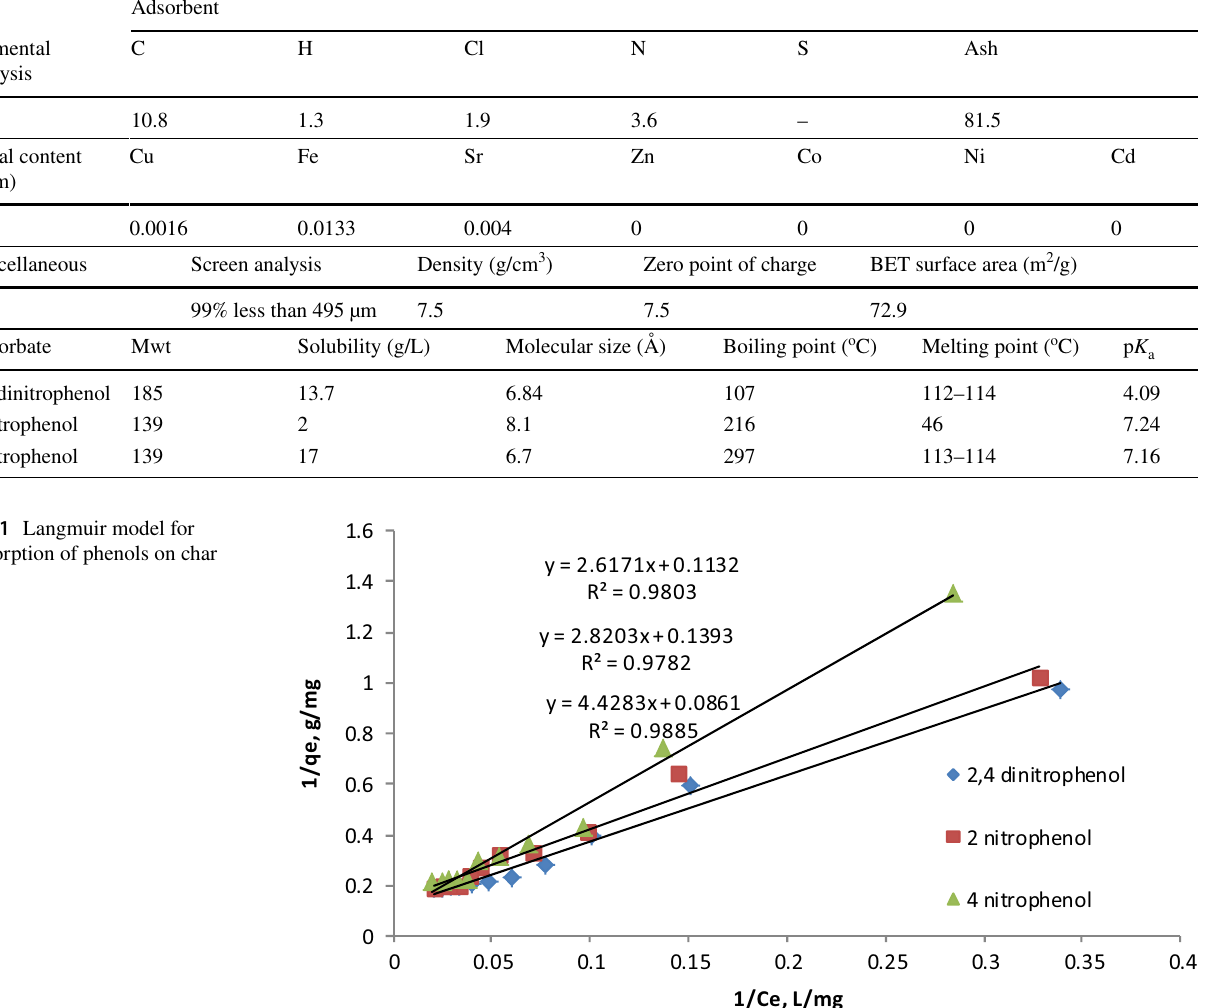
Table 1 Properties of adsorbent and adsorbates (Difullah et al. 1997) Adsorbent